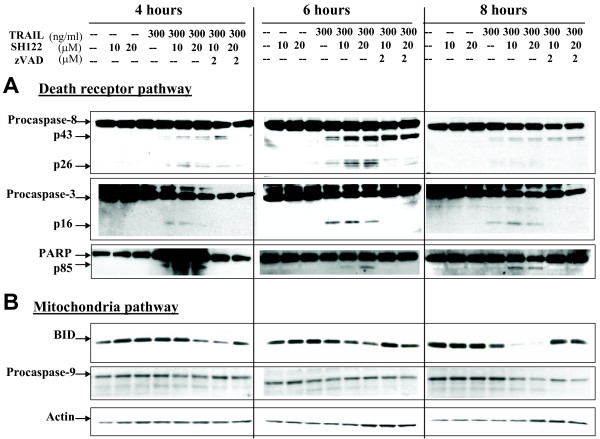
SH122 potentiated TRAIL-induced apoptosis by activating both the death-receptor pathway (A) and mitochondrial pathway (B). DU145 cells were treated with 10 and 20 μM of SH122, in the presence or absence of 300 ng/ml of TRAIL, with or without pretreatment with zVAD (2 μM), for 4, 6, and 8 h, respectively. Whole cell lysates (30 μg) were subjected to Western blot analysis. Membranes were probed with antibodies against caspase-8, caspase-3, caspase-9, PARP and Bid. Actin was shown as a loading control.